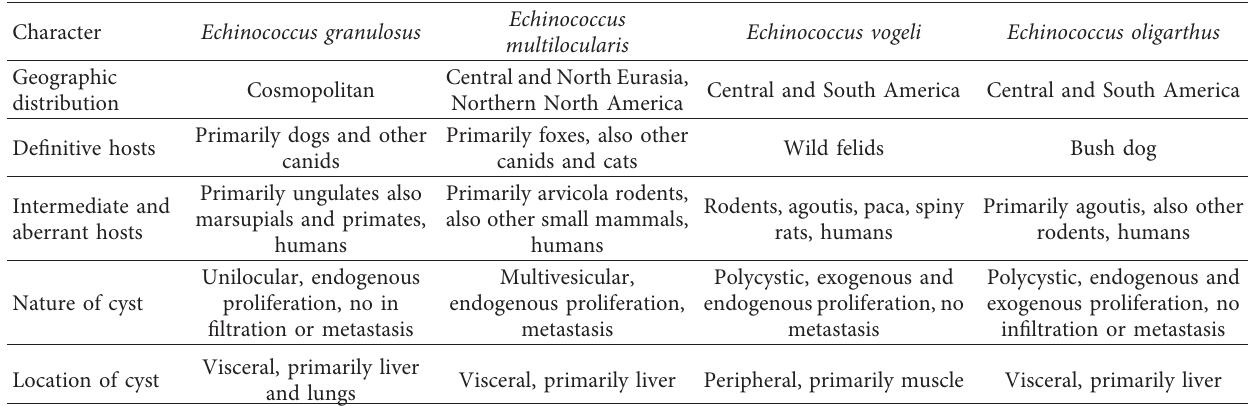
Table 1: Summary of the characteristics of Echinococcus Species.